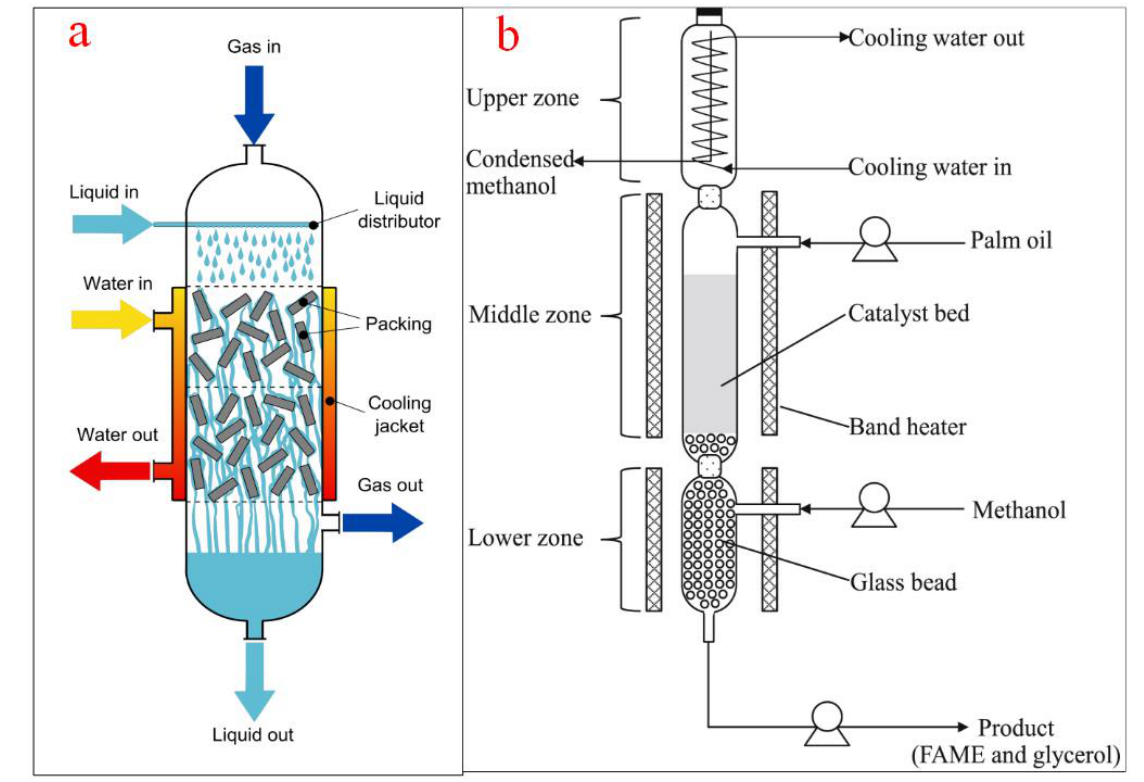
Figure 11. ( a ) Schematic representation of a trickle bed reactor; ( b ) a typical trickle bed reactor for biodiesel production. Adapted from